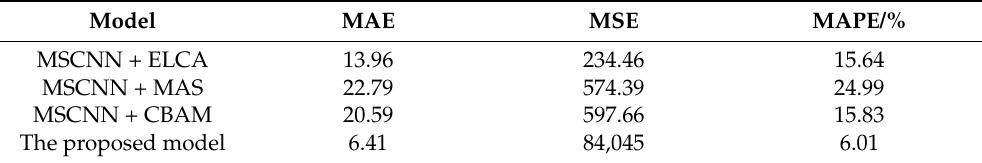
Table 5. Experimental results of adding white Gaussian noise to all signals.